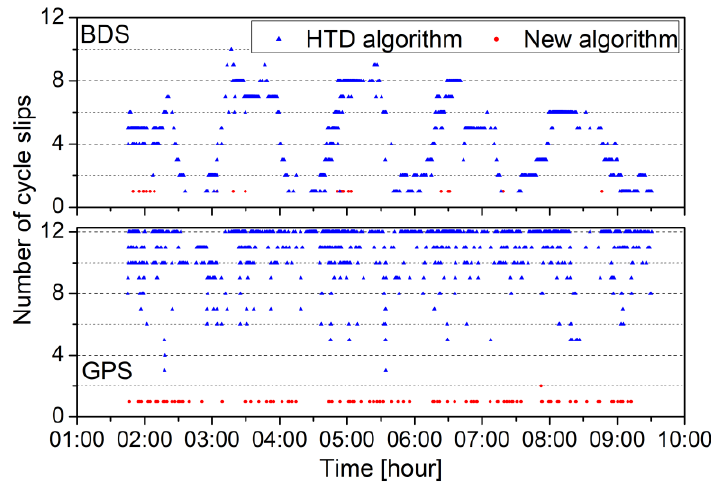
Figure 9. Number of GPS and BDS cycle slips detected by the HTD algorithm and the new algorithm considering the clock steering